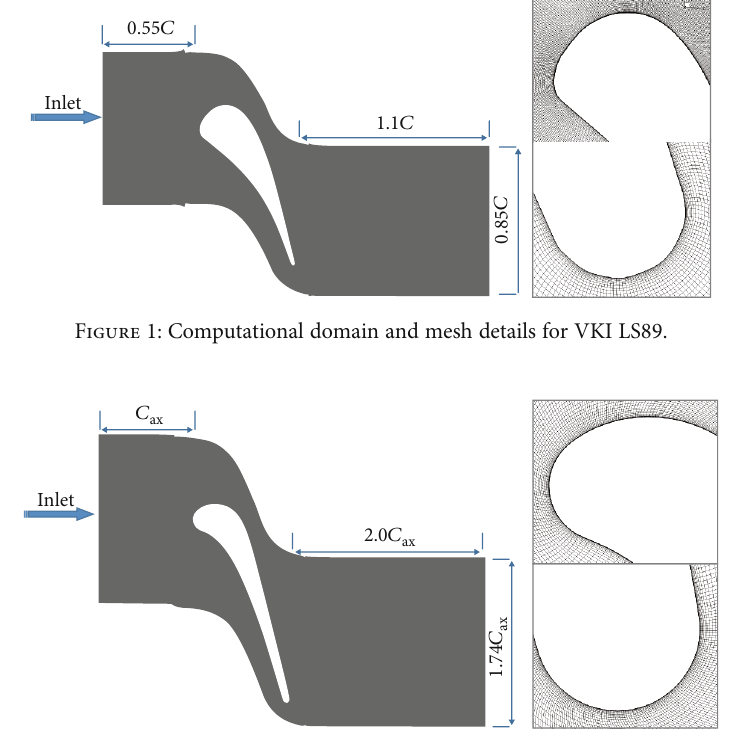
Figure 2: Computational domain and mesh details for the CNRC cascade. Table 2: Boundary conditions of research